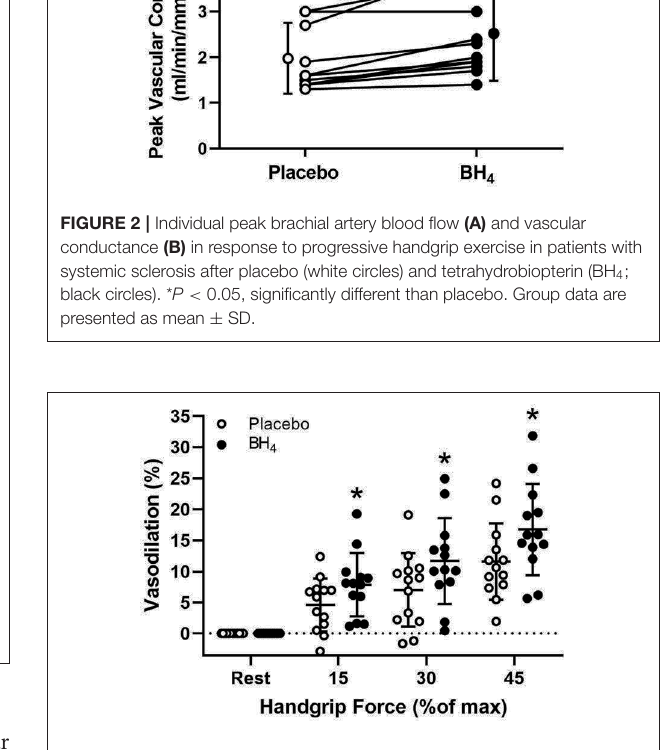
identical to the improvement in exercise-induced hyperemia ( Figure 1 ). The ability of resistance arteries to vasodilate during exercise is demonstrated by increases in blood flow and vascular conductance (25), both of which are partially mediated by NO (26, 27). Thus, one of the likely mechanisms for BH 4 -mediated improvements in exercise-induced blood flow and vascular conductance in this study are due to augmented resistance artery endothelial function. Although the role of NO in the regulation of exercising skeletal muscle blood flow continues